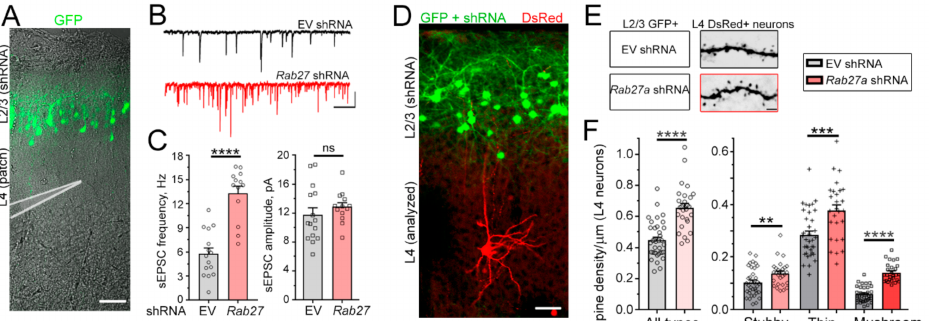
Figure 2. Rab27a knockdown in L2/3 (late-born) neurons alters glutamatergic transmission